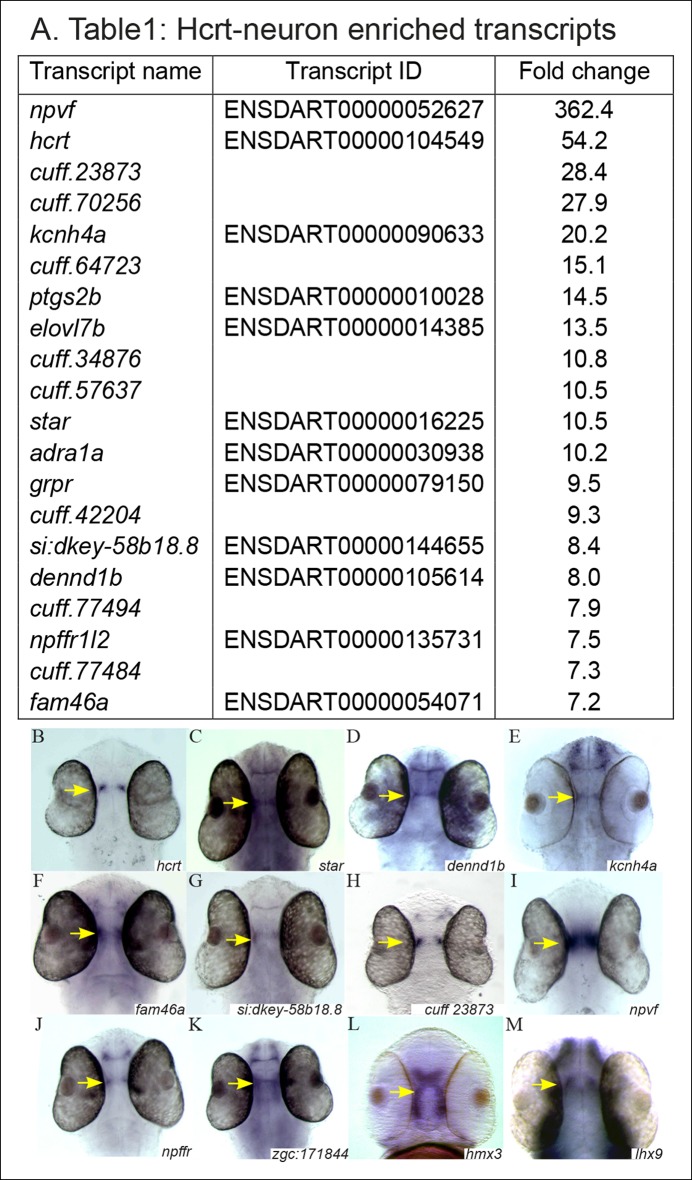
The expression pattern of selected candidate Hcrt-neuron–specific genes.(A) Table presenting the top 20 Hcrt-enriched transcripts. (B–M) Dorsal view of whole-mount ISH-stained 2 dpf WT larvae. Based on the RNA-seq and the bioinformatic analysis, the expression pattern of selected candidate Hcrt-neuron–specific genes was determined. The expression pattern of hcrt (B) was used for comparison.DOI:
http://dx.doi.org/10.7554/eLife.08638.00410.7554/eLife.08638.005Figure 2—source data 1.Hcrt-neuron enriched transcripts.All the genes detected have p <0.01 with Bonferroni correction for multiple testing (Materials and methods).